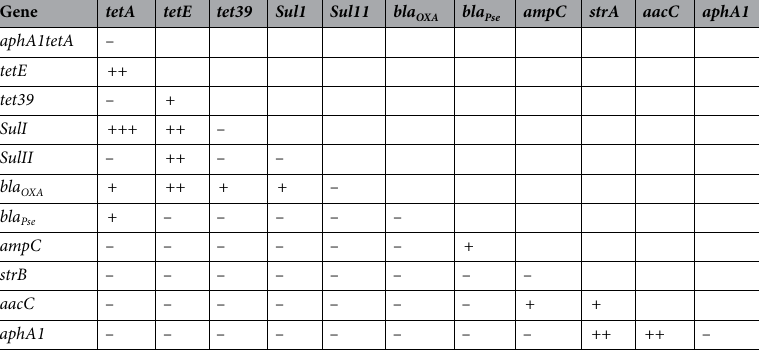
Table 4. Significance of Vibrio antibiotics resistance genes association a . a Only antibiotic resistance genes with a P 0.05 level of connection with another gene are shown. The level of significance was set at: P 0.05; +, P 0.01; ++, P 0.01; and +++, P 0.001 (as determined by the chi-square exact